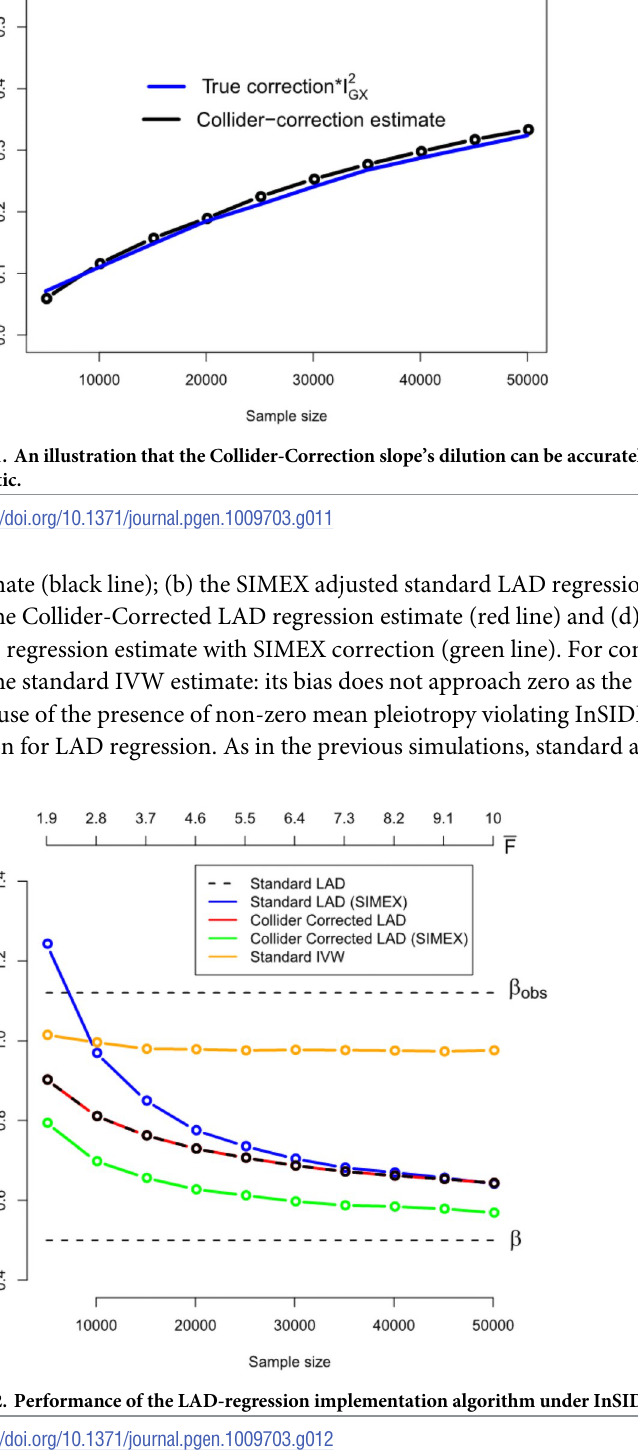
Fig 12. Performance of the LAD-regression implementation algorithm under InSIDE violating